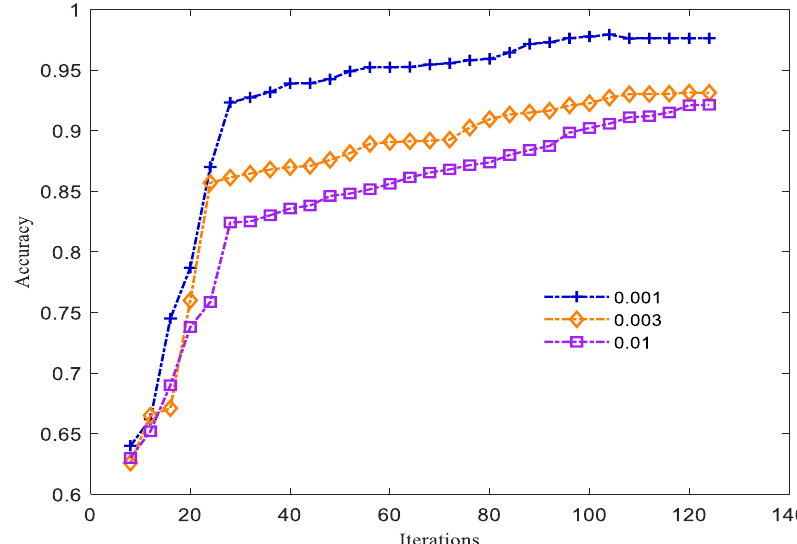
Figure 10. Accuracy with different learning rates.